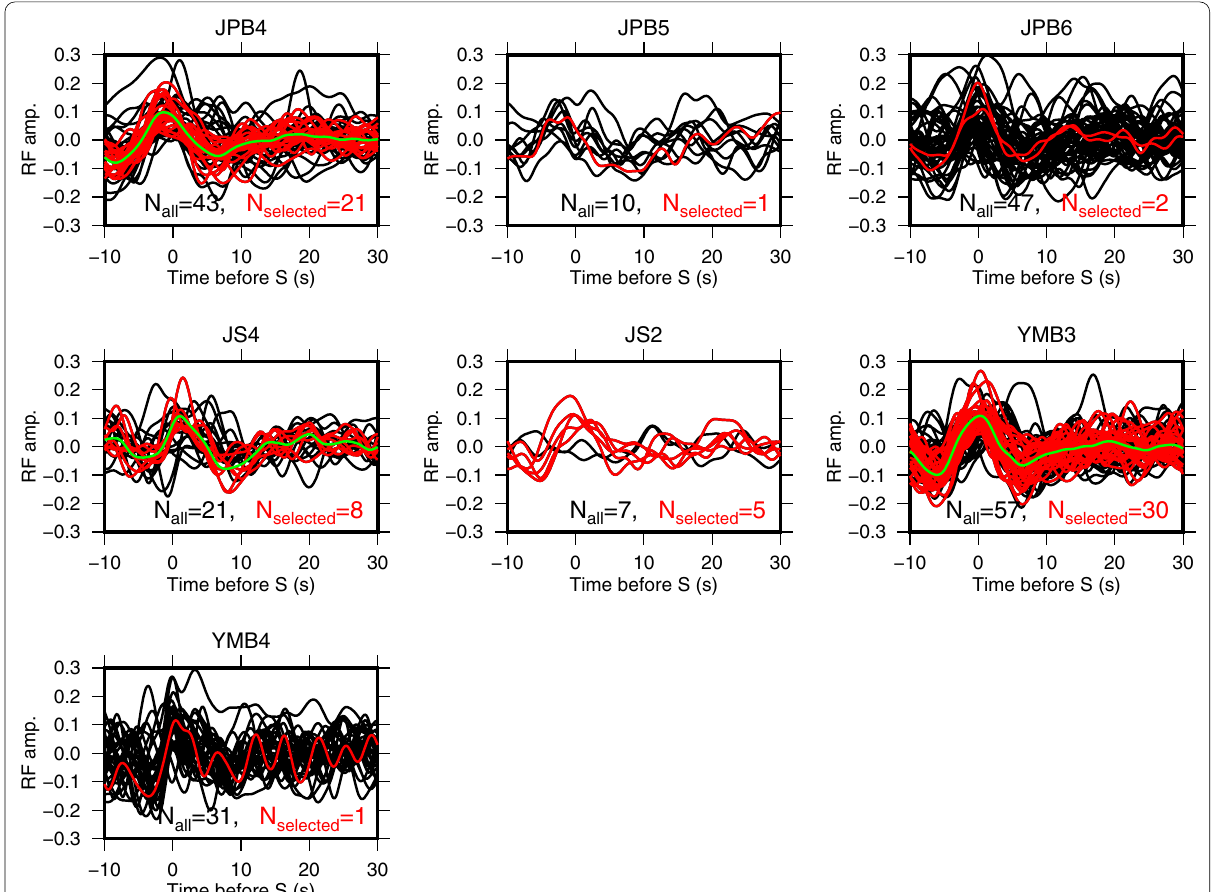
Fig. 3 S-receiver functions for each site. Black, red, and green traces represent rejected, accepted, and stacked receiver functions,